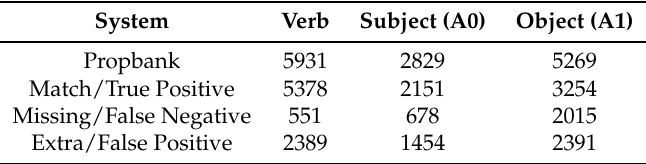
Table 8. Proposed system evaluation on Data set 1.